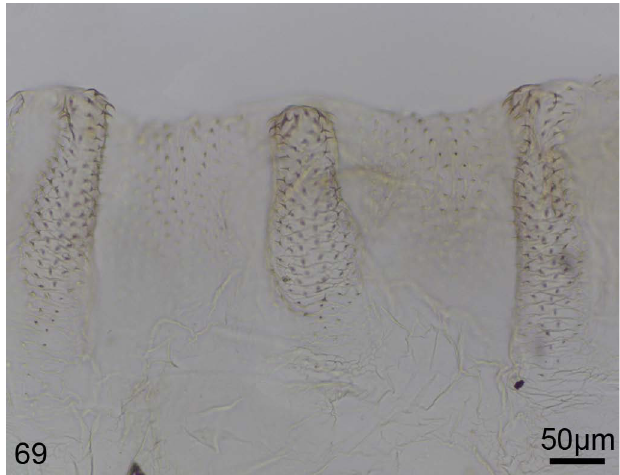
Fig 69. Enteric valve armature of Neocapritermes opacus .